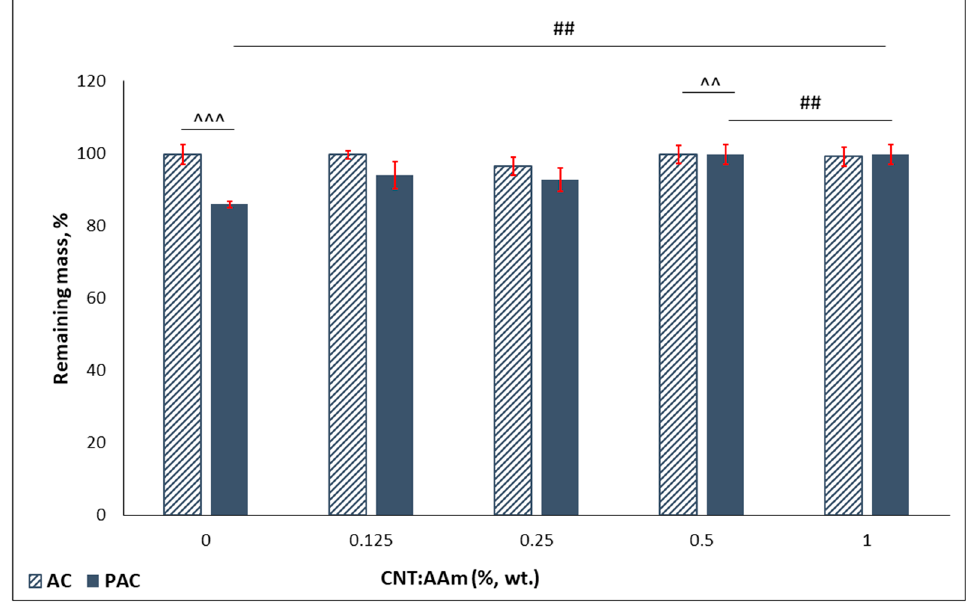
Figure 6. Hydrogels stability after 28 days incubation in PBS. Statistical significance: ^^, ## p < 0.01, ^^^ p < 0.001.